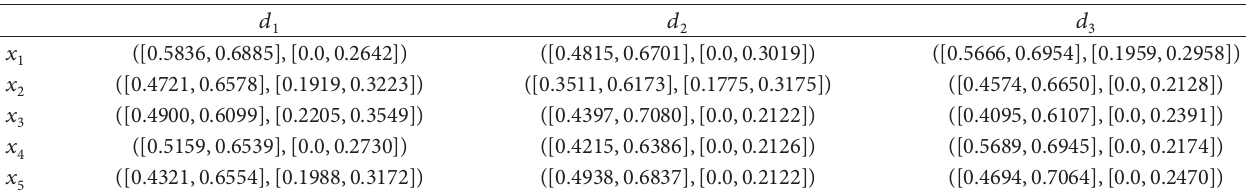
Table 4: Group decision matrix